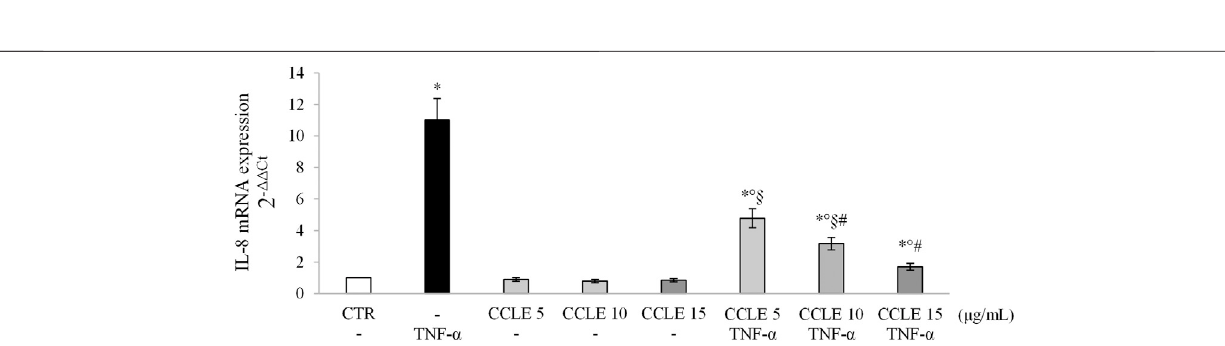
Frontiers in Pharmacology |